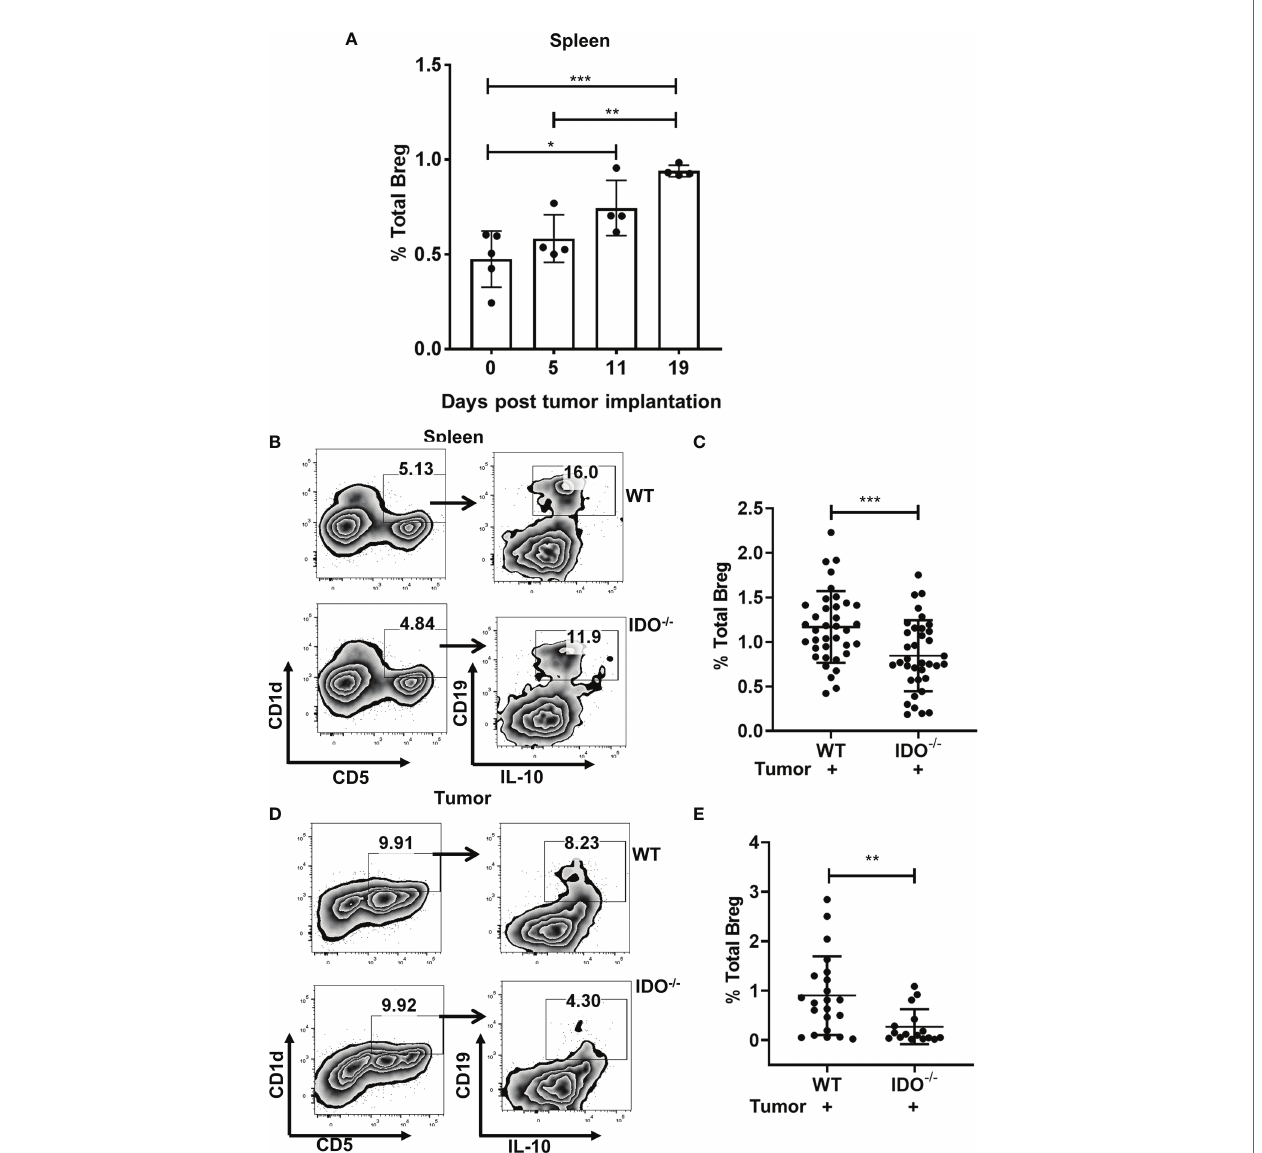
FIGURE 1 | IDO de fi ciency reduces Breg frequencies in lung cancer. (A) Time kinetics of in fi ltration of Bregs (CD19 + CD5 + CD1d hi IL-10 + ) during lung cancer progression in tumor-bearing wild type (WT) on Day 5,11 and 19 post i.v. injection of LLC compared to naïve WT mice (n = 4-5 mice per group). (B) Representative fi gure of FACS analyses of splenic tissue con fi rmed the reduction of Breg (CD19 + CD5 + CD1d hi IL-10 + ) in tumor-bearing IDO -/- on day 9 post tumor implant. (C) Total percentage of Bregs (CD19 + CD5 + CD1d hi IL-10 + ) in spleens of tumor-bearing WT and IDO -/- mice on Day 9 post tumor implant (n = 36-37 mice per group). (D) Representative fi gure of FACS analyses of lung tumor tissue con fi rmed reduction of Breg (CD19 + CD5 + CD1d hi IL-10 + ) in tumor-bearing IDO -/- on day 9 post tumor implant. (E) Total percentage of Breg (CD19 + CD5 + CD1d hi IL-10 + ) in lung tumors of WT and IDO -/- mice on Day 9 post tumor implant (n = 16-22 mice per group). *p < 0.05, **p < 0.001, ***p <